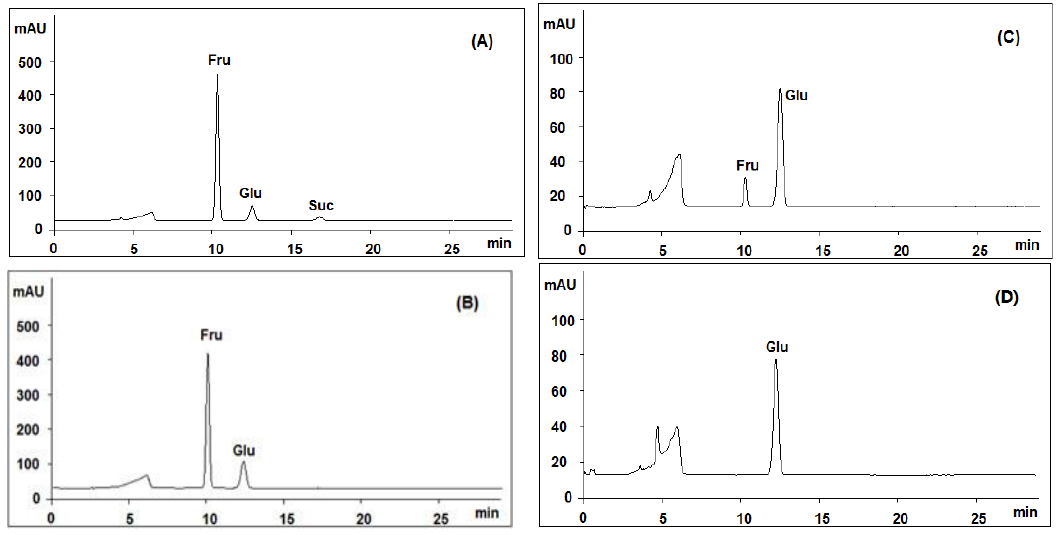
Figure 3. Comparative analysis of the products generated by acid hydrolysis of SQI sample at different concentrations of trifluoroacetic acid (TFA): ( A ) 0 M; ( B ) 0.02 M; ( C ) 1 M; ( D ) 2 M; using HPLC-ELSD coupled with an Asahipak Amino P-50 4E column.